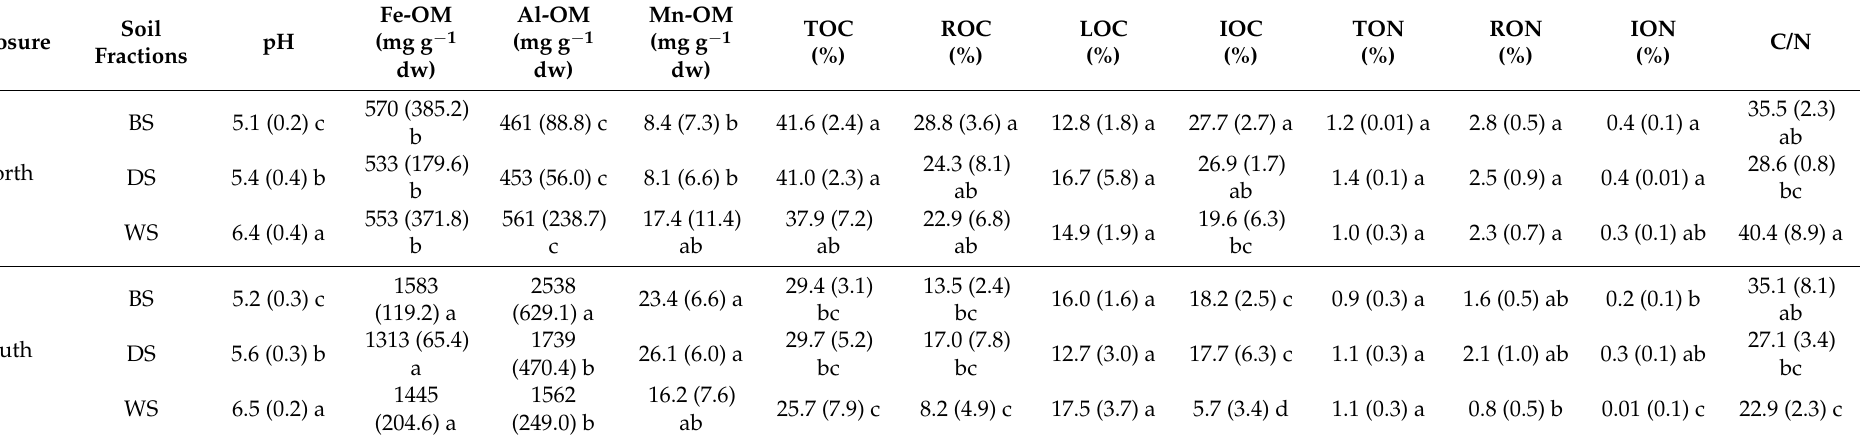
Table 1. Overview of the physico-chemical properties recorded in the bulk soil and the aggregate size fractions (dry-sieved and water-stable 1.00–0.50 mm) in the organic (OF) horizon at the north- and the south-facing sites. Values are means ( n = 3) with the standard deviations in brackets. Data are expressed on a dry weight basis. In each column, different letters indicate significant differences ( p < 0.05 according to Duncan post-hoc test) among the soil fractions (bulk soil [BS],